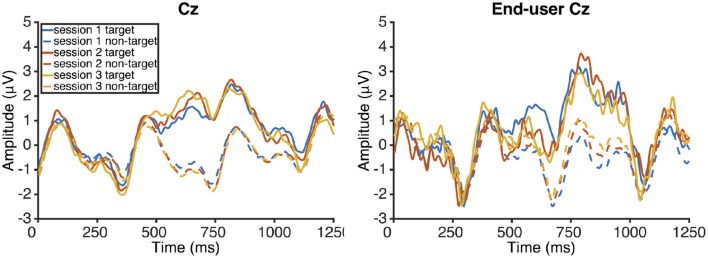
ERP responses of the healthy participants in sessions one, two, and three (top left). The ERPs end-user one, who used the same system as the healthy controls, are shown top right. The continuous lines show target responses, the dashed lines non-target responses.